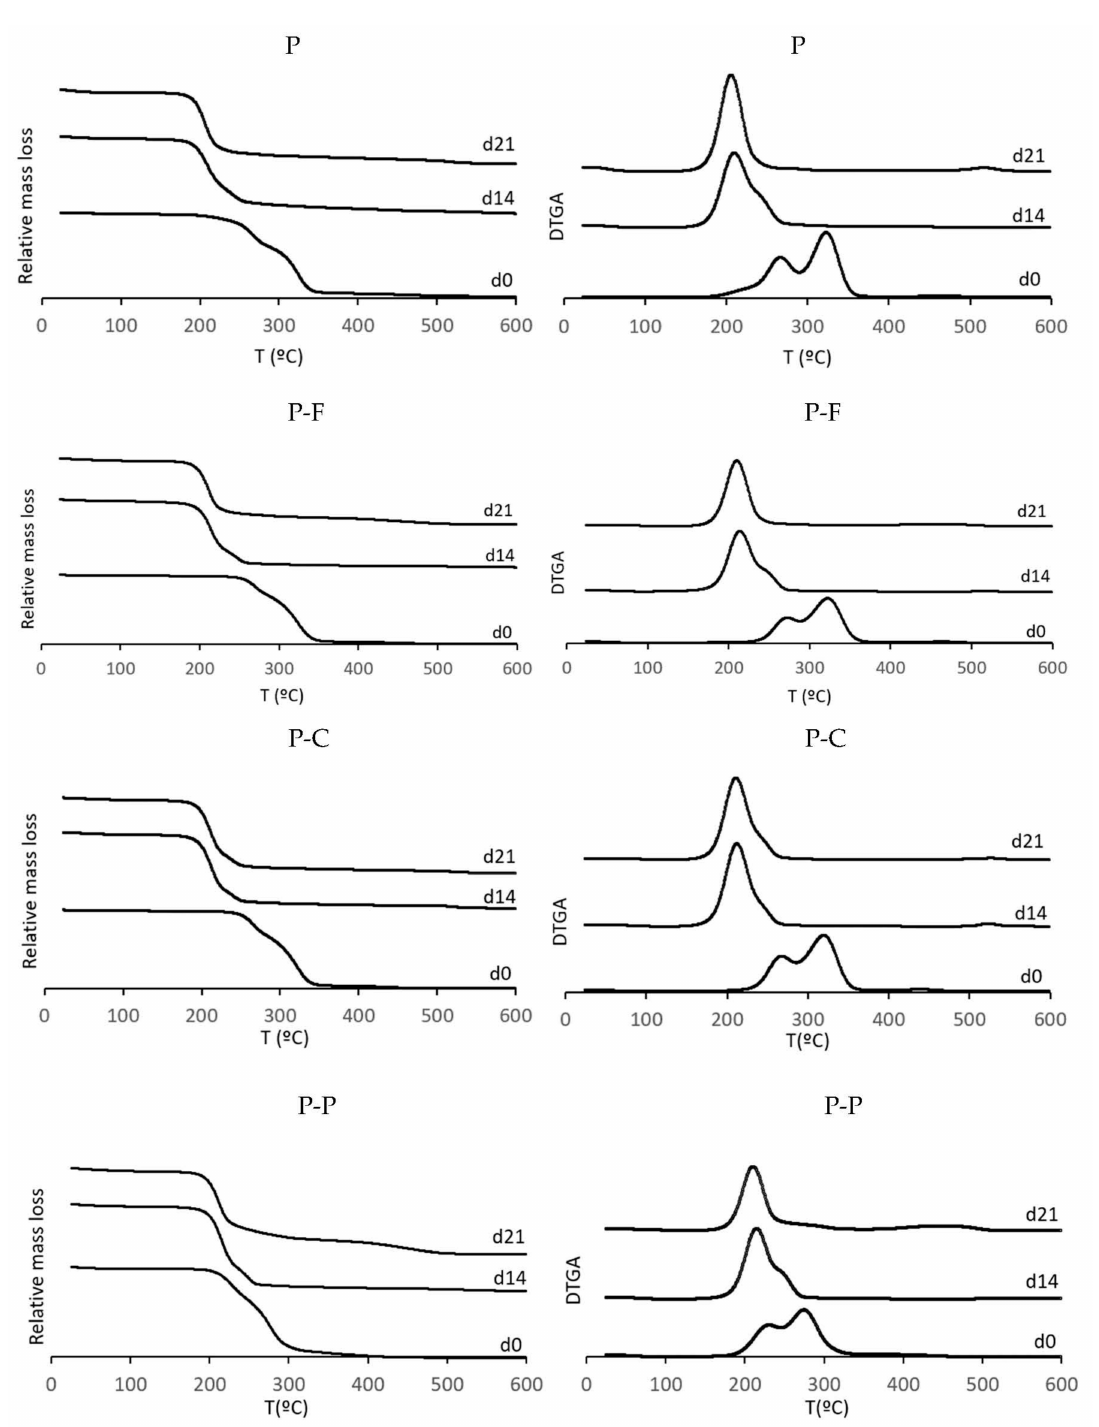
Figure 3. TGA and DGTA curves of PLA-PHBV blend films (P) and PLA-PHBV blend films containing ferulic acid (P-F), p -coumaric acid (P-C) and protocatechuic acid (P-P), after different composting times (0, 14 and 21